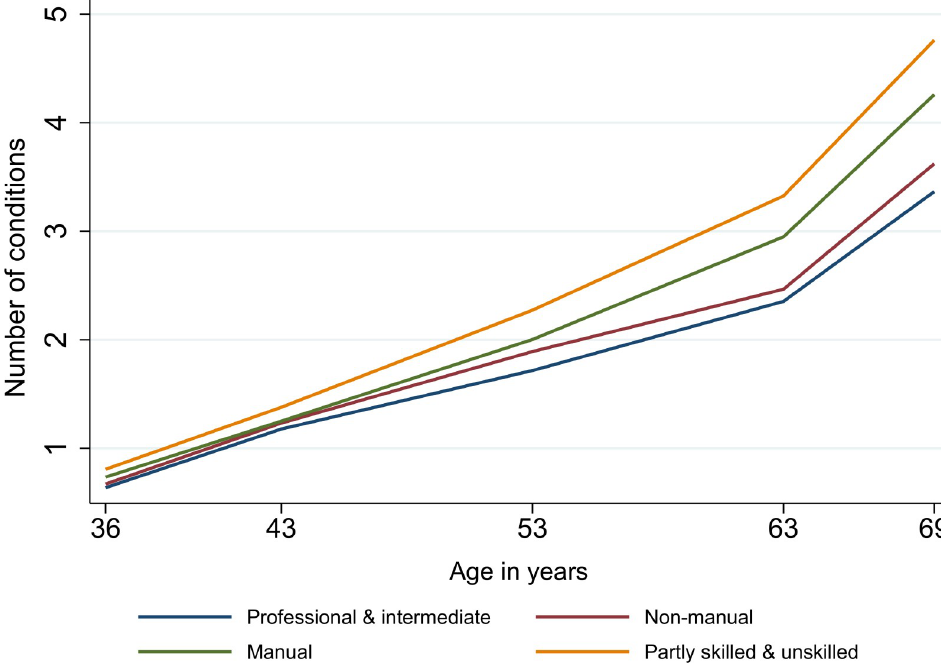
Fig 4. Socioeconomic inequalities in multimorbidity trajectories by adulthood social class in 3,723 participants from the 1946 MRC NSHD. Note: Fig 4 is based on Model 3 in Table G and adjusted for sex, childhood social class, and educational level. NSHD, National Survey of Health and